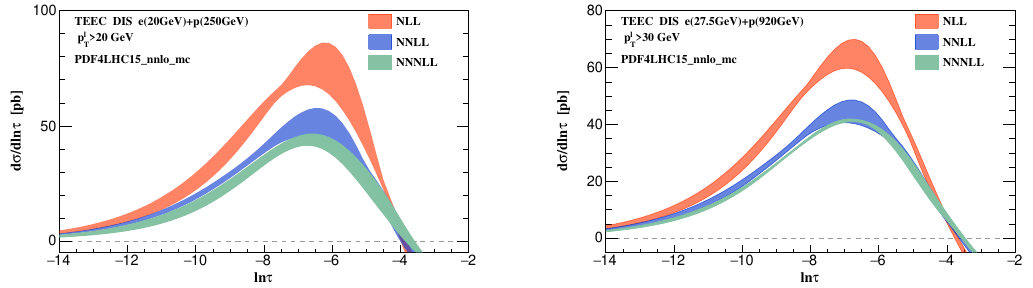
Figure 2 . Fixed-order results for the ln τ distributions in the back-to-back limit for (left) and 318 GeV(right) ep collisions. The full QCD (dash lines) and non-singular (dash-dotted lines) distributions are shown up to NLO, while the leading singular (solid lines) distributions are up to NNLO.